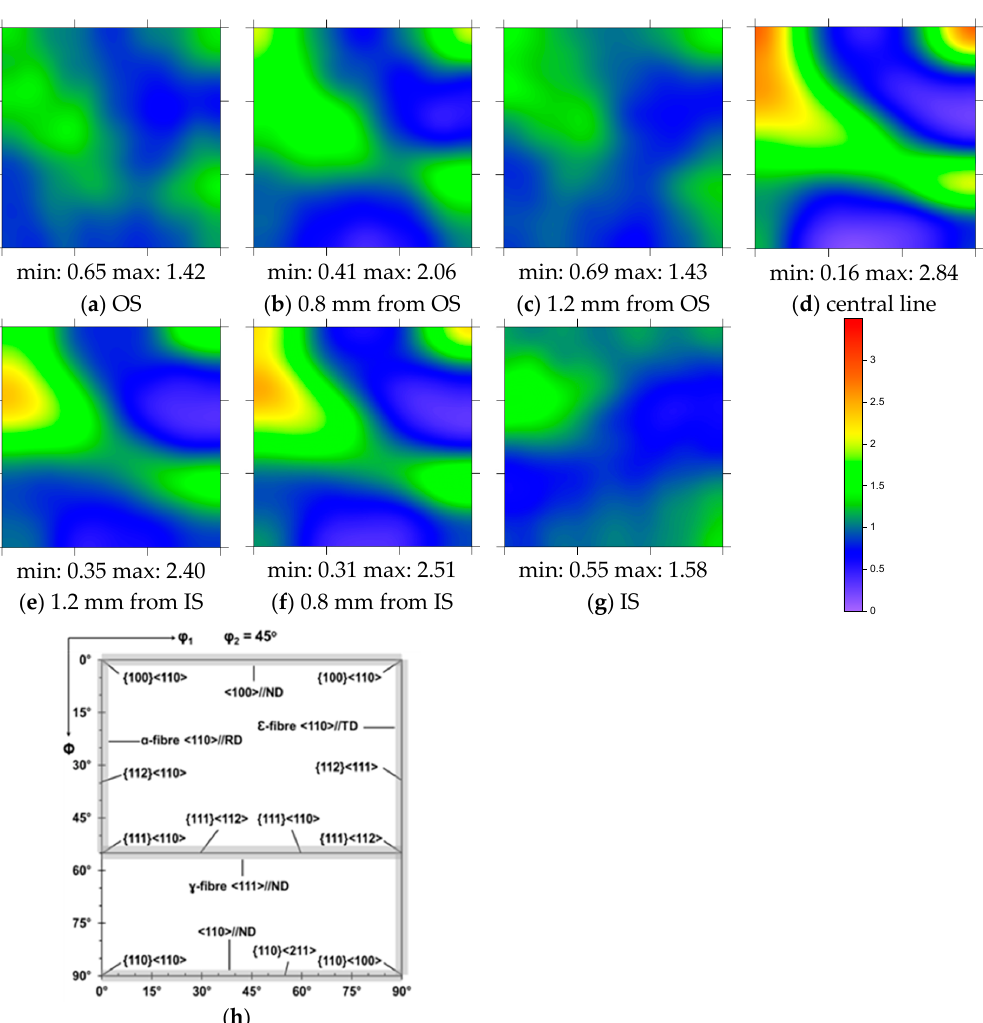
Figure 5. ODFs at φ 2 = 45° section: ( a ) At the outer surface (OS); ( b ) At 0.8 mm from OS; ( c ) At 1.2 mm from OS; ( d ) At the pipe central line; ( e ) At 1.2 mm from inner surface (IS); ( f ) At 0.8 mm from IS; ( g ) At the inner surface; ( h ) Schematic representation of the major texture components (where ND, TD, and RD are, respectively, the normal, transverse, and rolling directions).